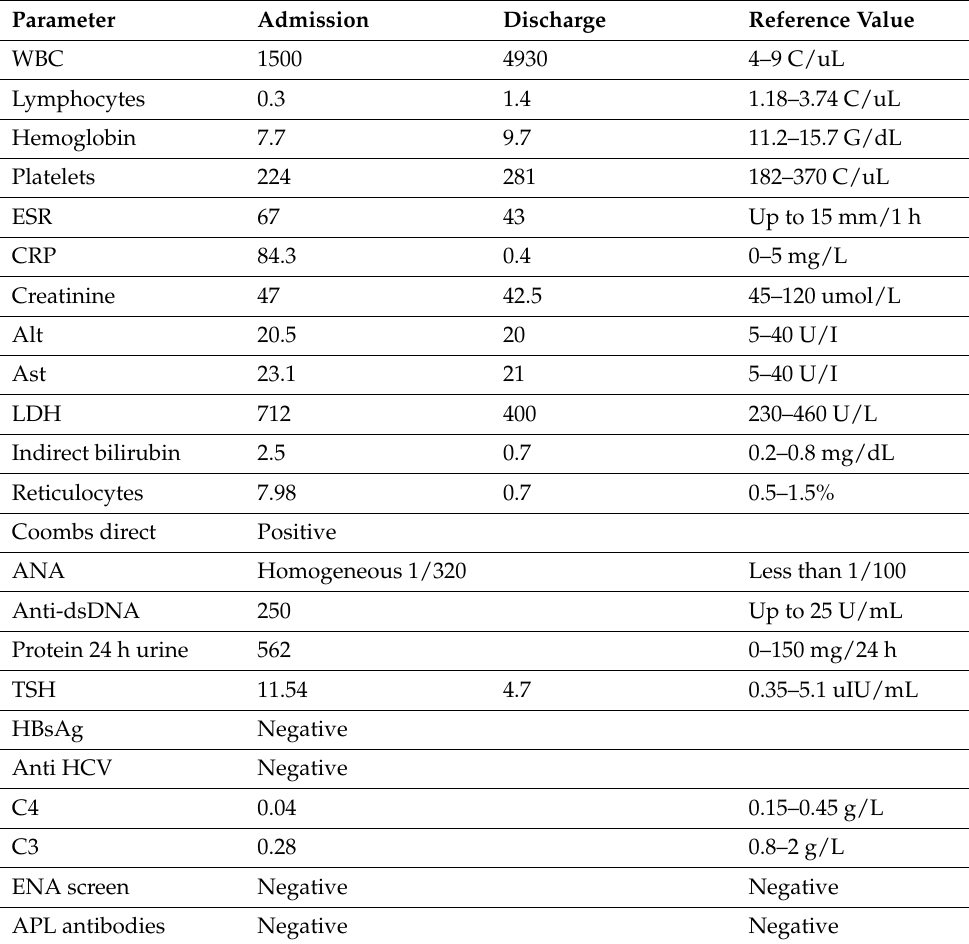
Table 1. Laboratory results on admission and